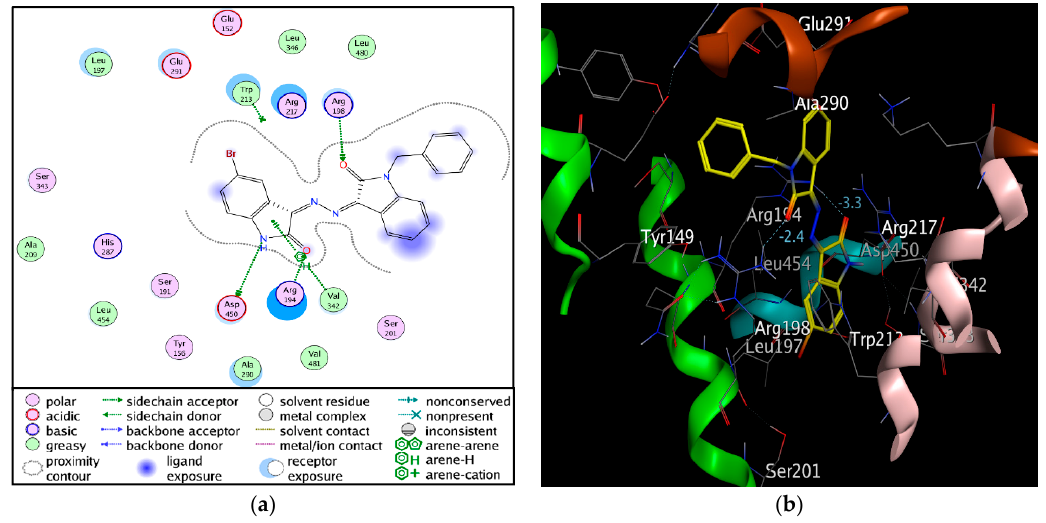
Figure 12. ( a ) A schematic demonstration, and ( b ) A cartoon illustration of the amino acids included in compound 3 -BSA binding within the BSA site I binding pocket. Table 5. Summary of the docking data obtained for compound 3 and BSA.